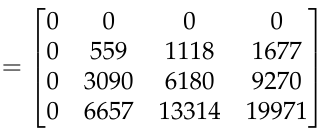
Figure 11. Results array z